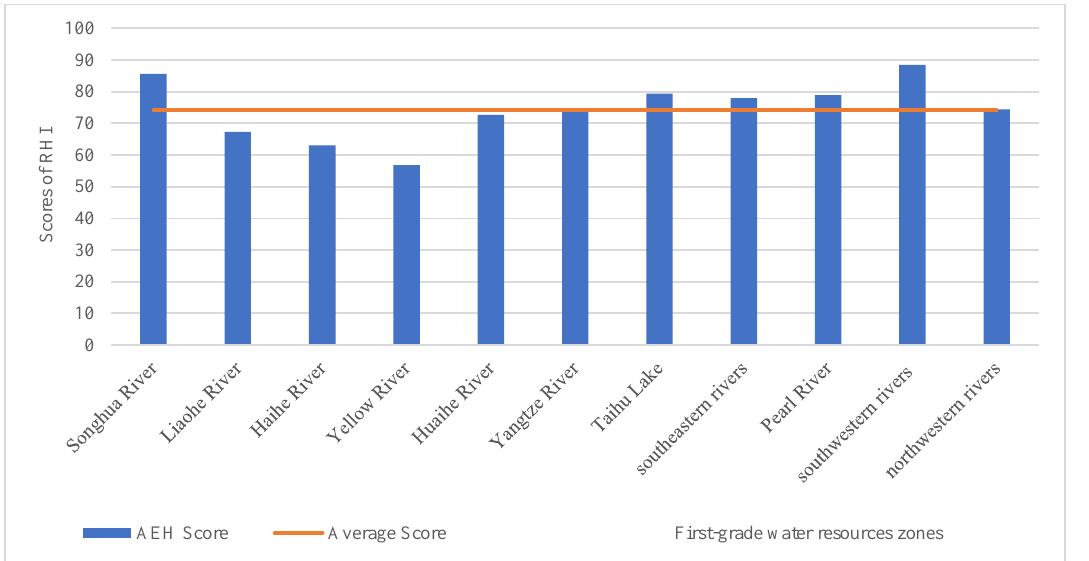
Figure 7. WCP evaluation results for Chi na’s first -grade water resource zones.